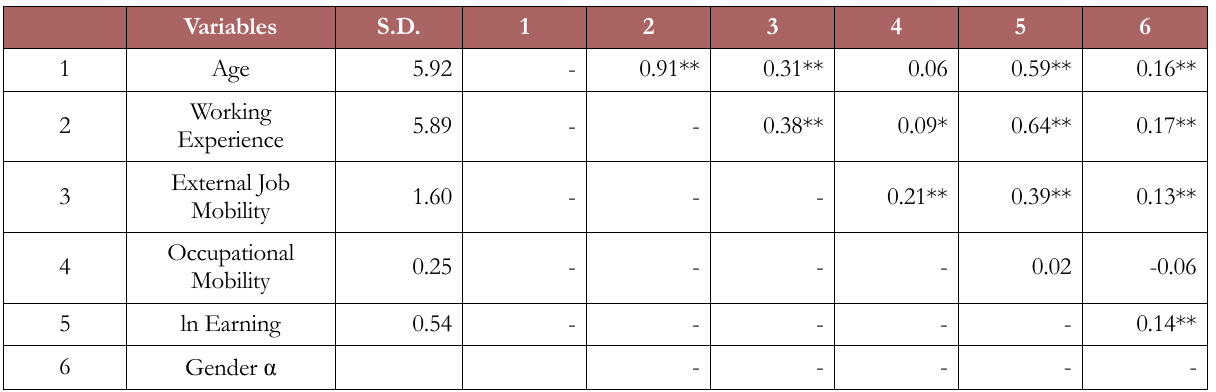
Table 4. Standard deviations and correlations of variables